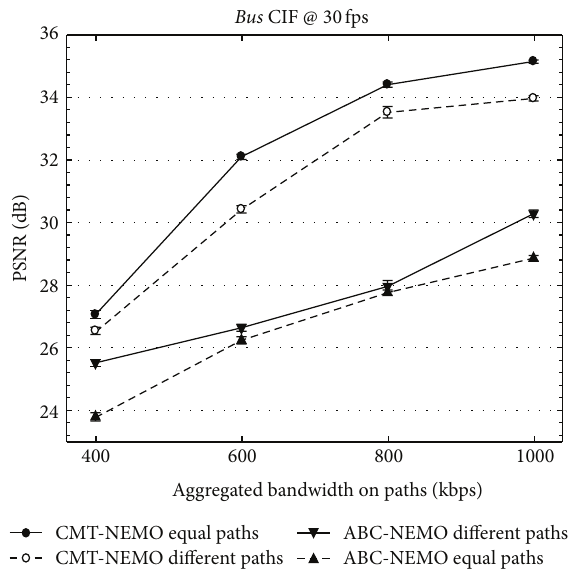
Figure 10: Comparison of schemes for the Bus sequence at 30fps.